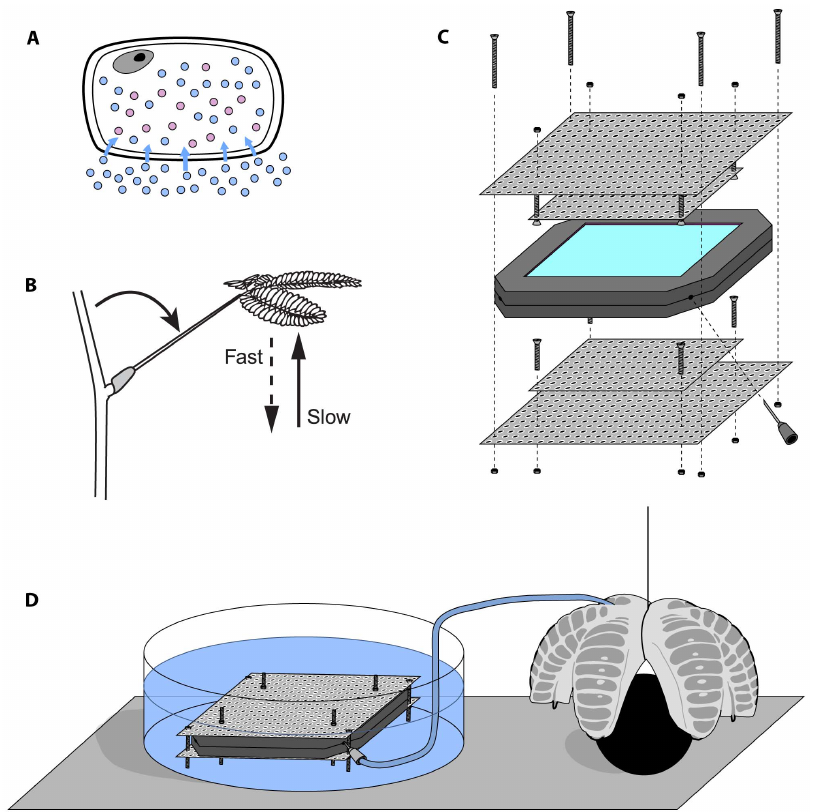
Figure 1. Biological and bioinspired pressure generation and actuation. A . Generation of turgor pressure due to an osmotic gradient across the semi-permeable cell membrane of a plant. Blue circles represent water molecules; red circles represent solute molecules. B . The nastic motion of mimosa pudica . Adapted from Dumais and Forterre, 2012 [52]. C . Prototype pressure generator consisting of a restrained dialysis cassette filled with working fluid used in this work. D . Schematic of the pressure generator being used to actuate a soft robotic gripper.